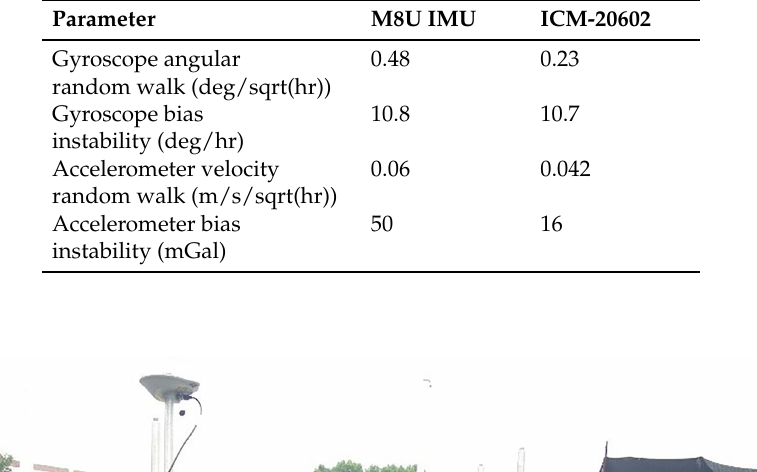
Table 1. M8U IMU and ICM-20602 static AVAR. analysis parameters